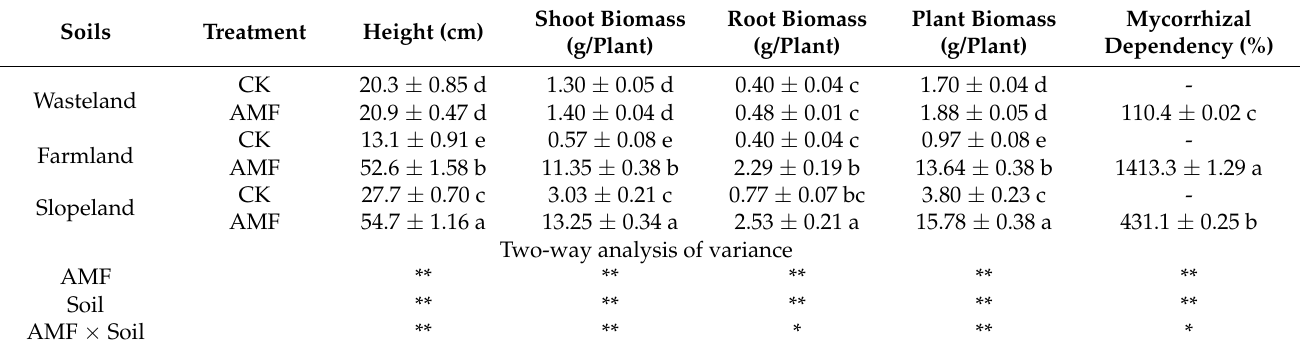
Table 3. Effects of AMF on maize plant height and biomass. The different lowercase letters indicate significant differences among treatments; “ns” “*” and “**” mean p < 0.05 and p < 0.01 according to two-way analysis of variance,